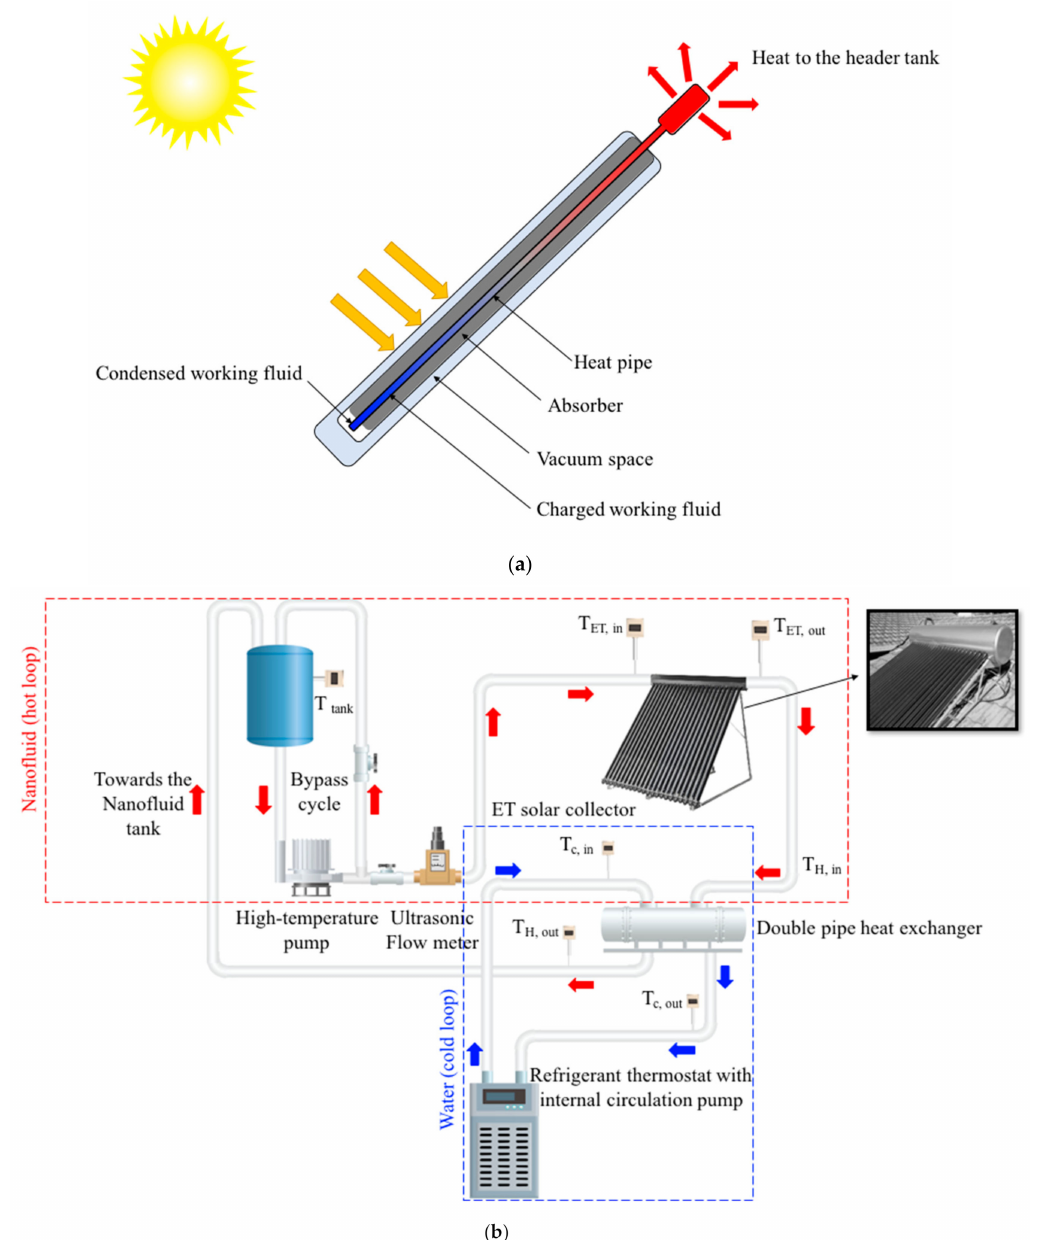
Figure 10. Schematic diagram of the test facility used in the present study, ( a ) the structure of the evacuated tube utilized in the solar collector, ( b ) the test rig [40]. Figure is reprinted with permission from